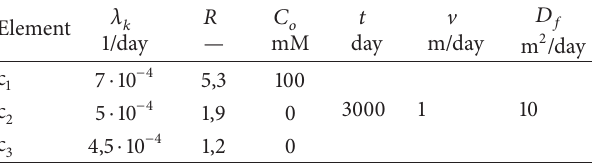
Table 1: Physical parameters used in simulation.